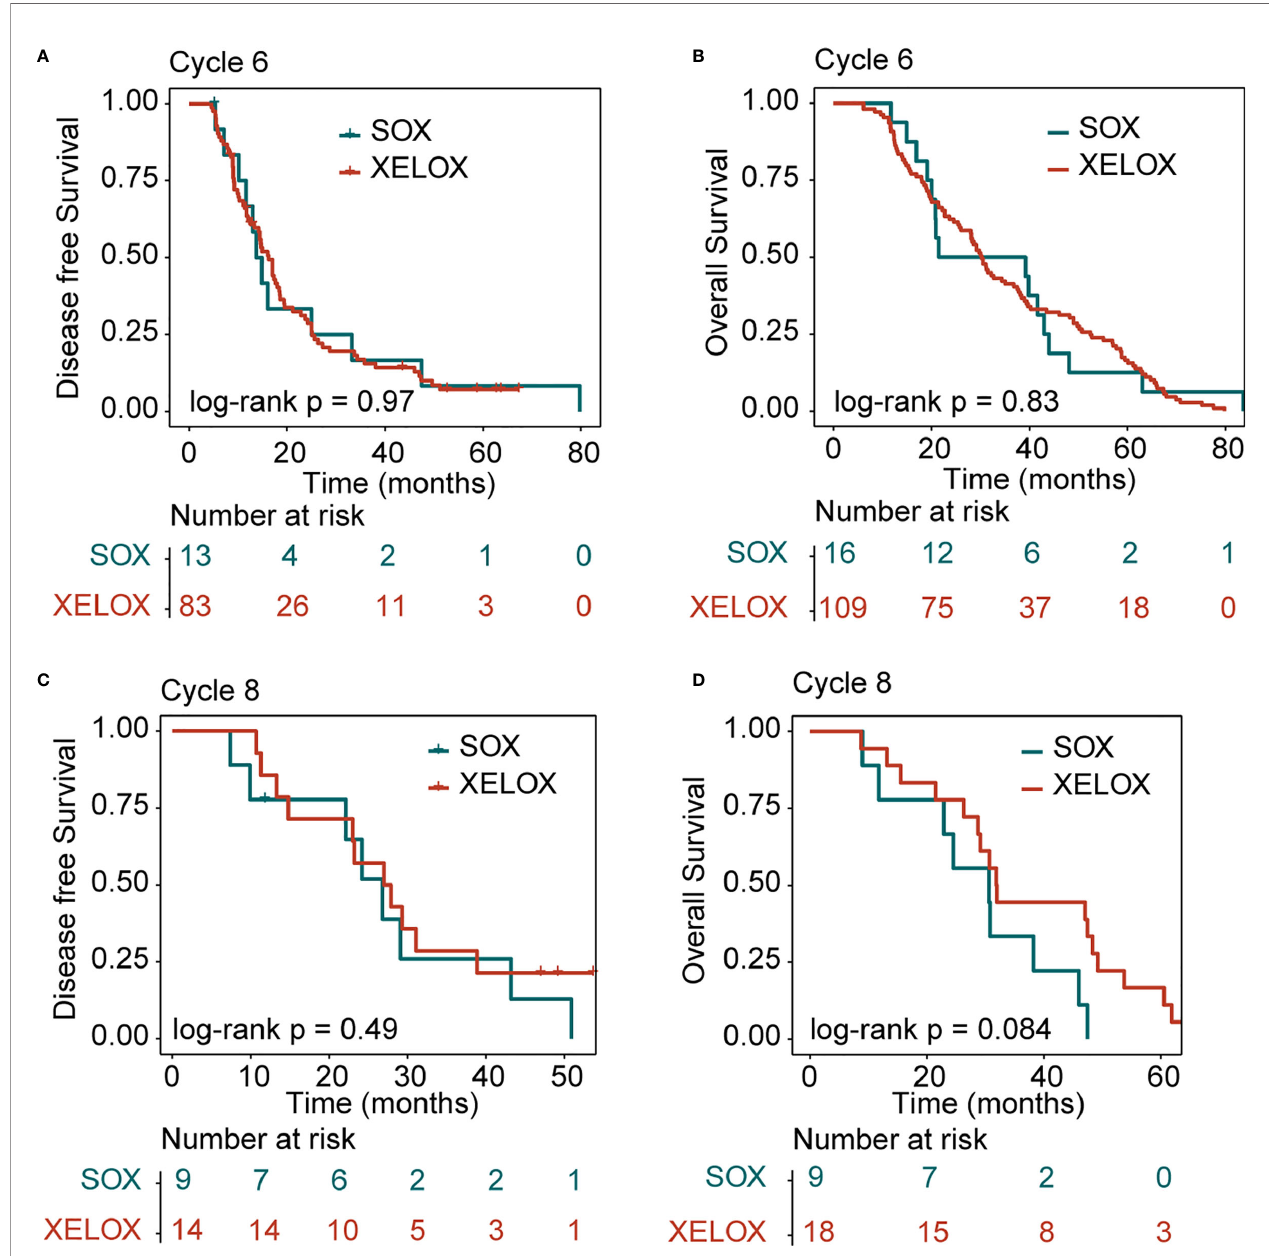
FIGURE 2 | Kaplan-Meier survival curves for disease-free survival (DFS) and overall survival (OS). DFS (A) and OS (B) analyses for the XELOX and SOX regimens for patients with stage II and stage III gastric cancer receiving six cycles of chemotherapy. DFS (C) and OS (D) analyses for the XELOX and SOX regimens for patients with stage II and stage III gastric cancer receiving eight cycles of chemotherapy. XELOX, Capecitabine plus oxaliplatin; SOX, S-1 plus